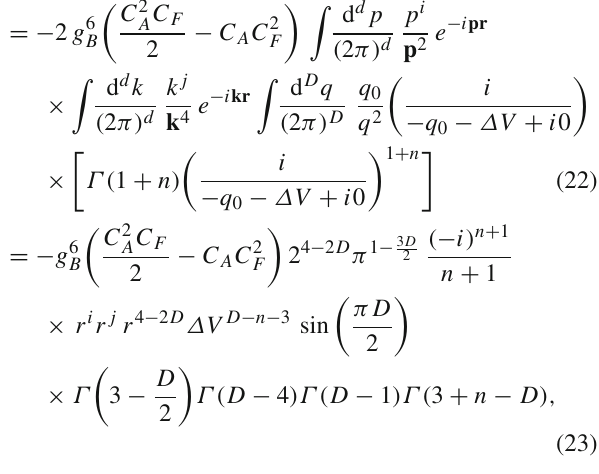
Fig. 4 Sample diagram (3 d ) ( 2 , 0 ) contributing to δ E and US δ E ( 1 , 0 ) , with time labels on the US upper Wilson-line vertices and indicated potential three-momentum flow. The thick red lines mark the time interval, where the static quark pair is in a color-octet state